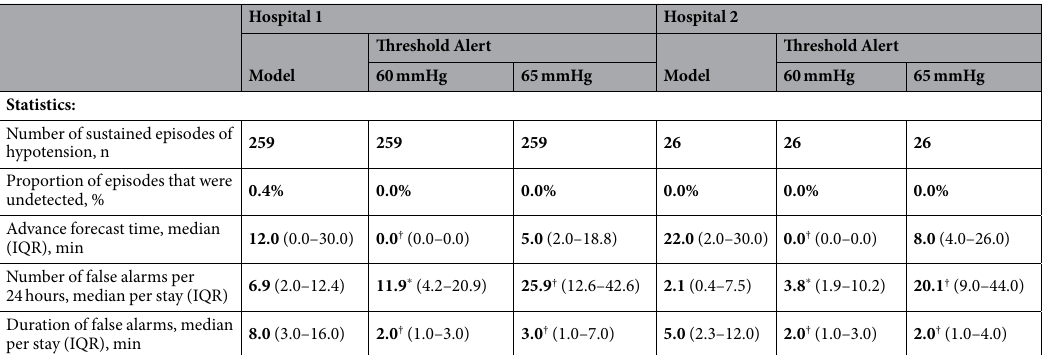
Table 5. Performance of the logistic regression model versus two simple threshold alerts. Hypotension is defined as MAP < 60 mmHg and sustained episode of hypotension is defined as ≥ 15 min. An episode of hypotension was “detected” if, directly upon its onset, there had been an alarm episode in the preceding 30 min. An alarm episode (defined as the continuous time interval when the alarm condition was true) was a “false alarm” if, directly upon its onset, there was no sustained hypotension commencing within 30 min. * Significant difference between model and threshold alert, P < 0.05. † Significant difference between model and threshold alert, P <